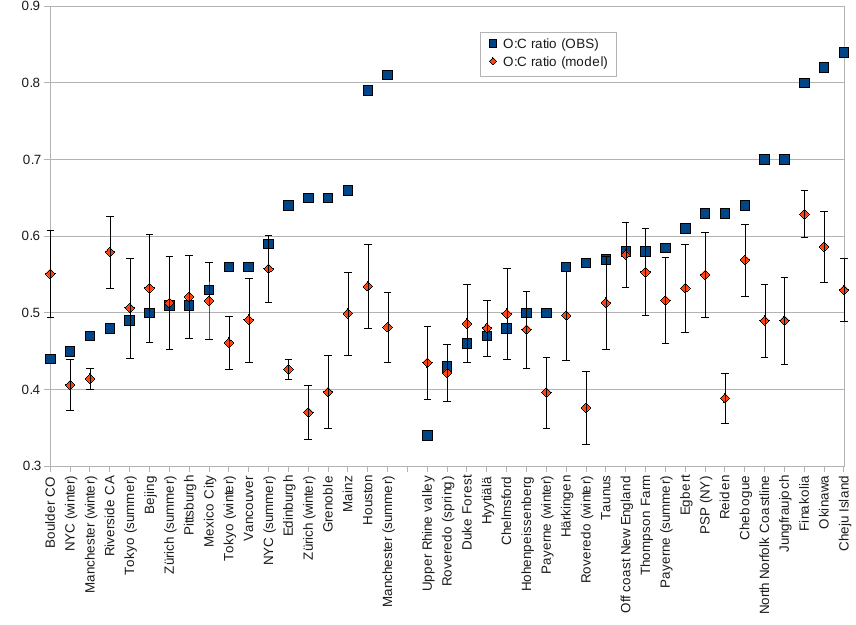
Fig. 4. Comparison of the simulated O:C ratios in the surface layer and a collection of observed O:C ratios from various measurement campaigns using different methods and instruments collected and described by Ng et al. (2010). The blue symbols denote the observed values and the red symbols the simulated mean values during the period of the campaign sampled at the station location. Note, that due to the limited simulation period, the exact year of the observations is not reproduced explaining some of the deviations. The error bars denote the temporal model standard deviation ( ± 1 σ range).